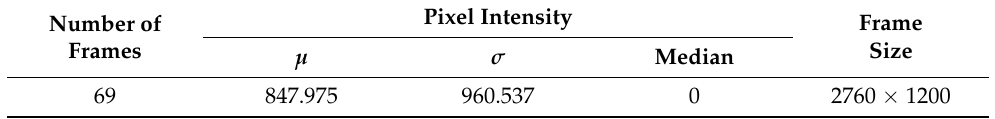
Table 3. Statistical properties of the original images (average of the given dataset).